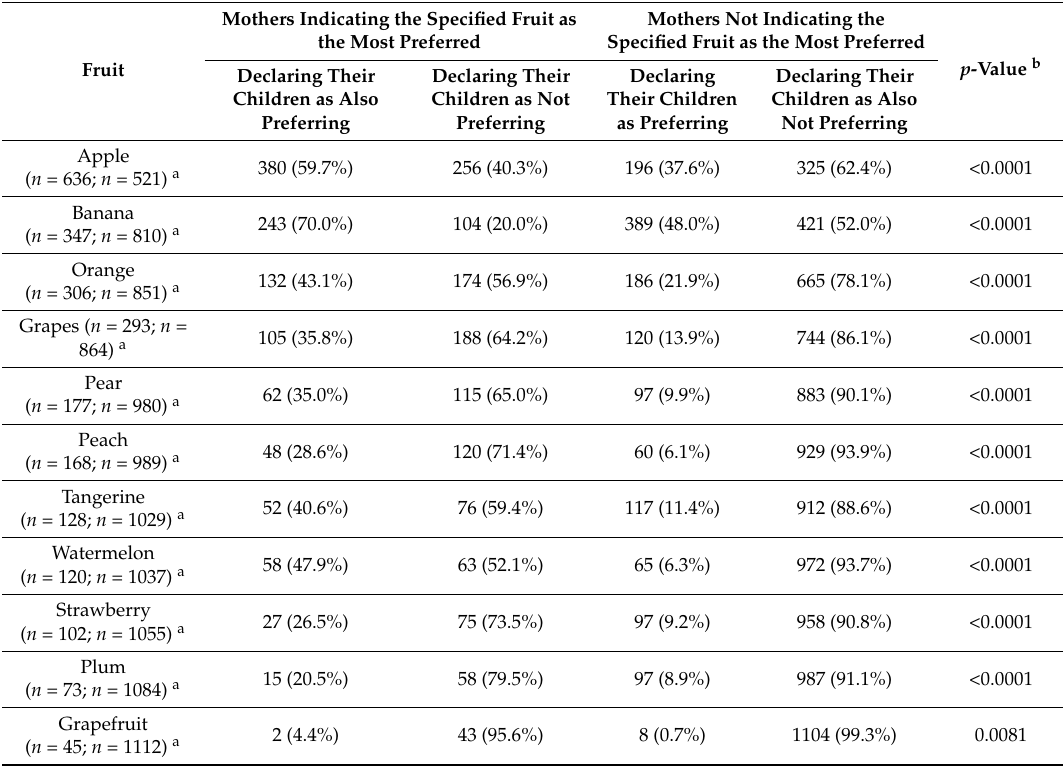
Table 4. Analysis of the association between the fruit preferences of mothers and their declared fruit preferences of their children in a national sample of Romanian respondents ( n = 1157).